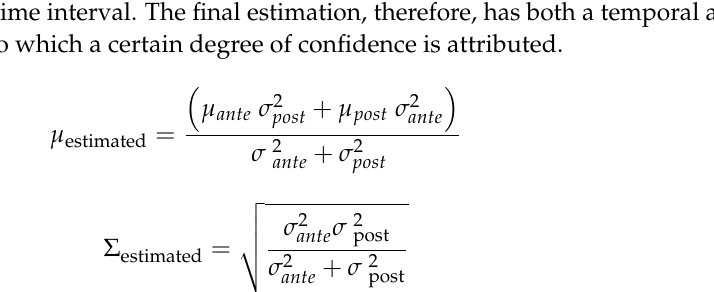
Figure 2. Methodological flow.